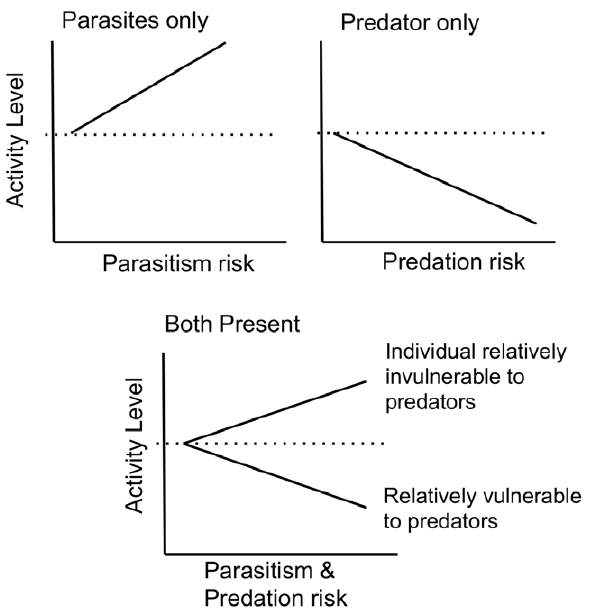
Figure 1. Response of tadpoles to the presence of parasites and predators and the hypothesized response to the presence of both, which will depend on the relative vulnerability of the tadpole to the predator. The dotted line in each plot represents baseline activity level, i.e. the activity level of the tadpole when no predator or parasite is present. We hypothesize that species such as Lithobates sylvaticus , which is highly vulnerable to fish predators, will show decreased activity in the presence of both fish and